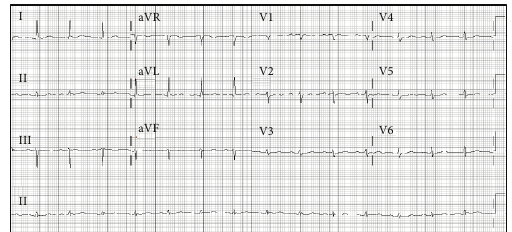
Figure 2: Repeat electrocardiogram on the following morning showing return of the ST-segments to